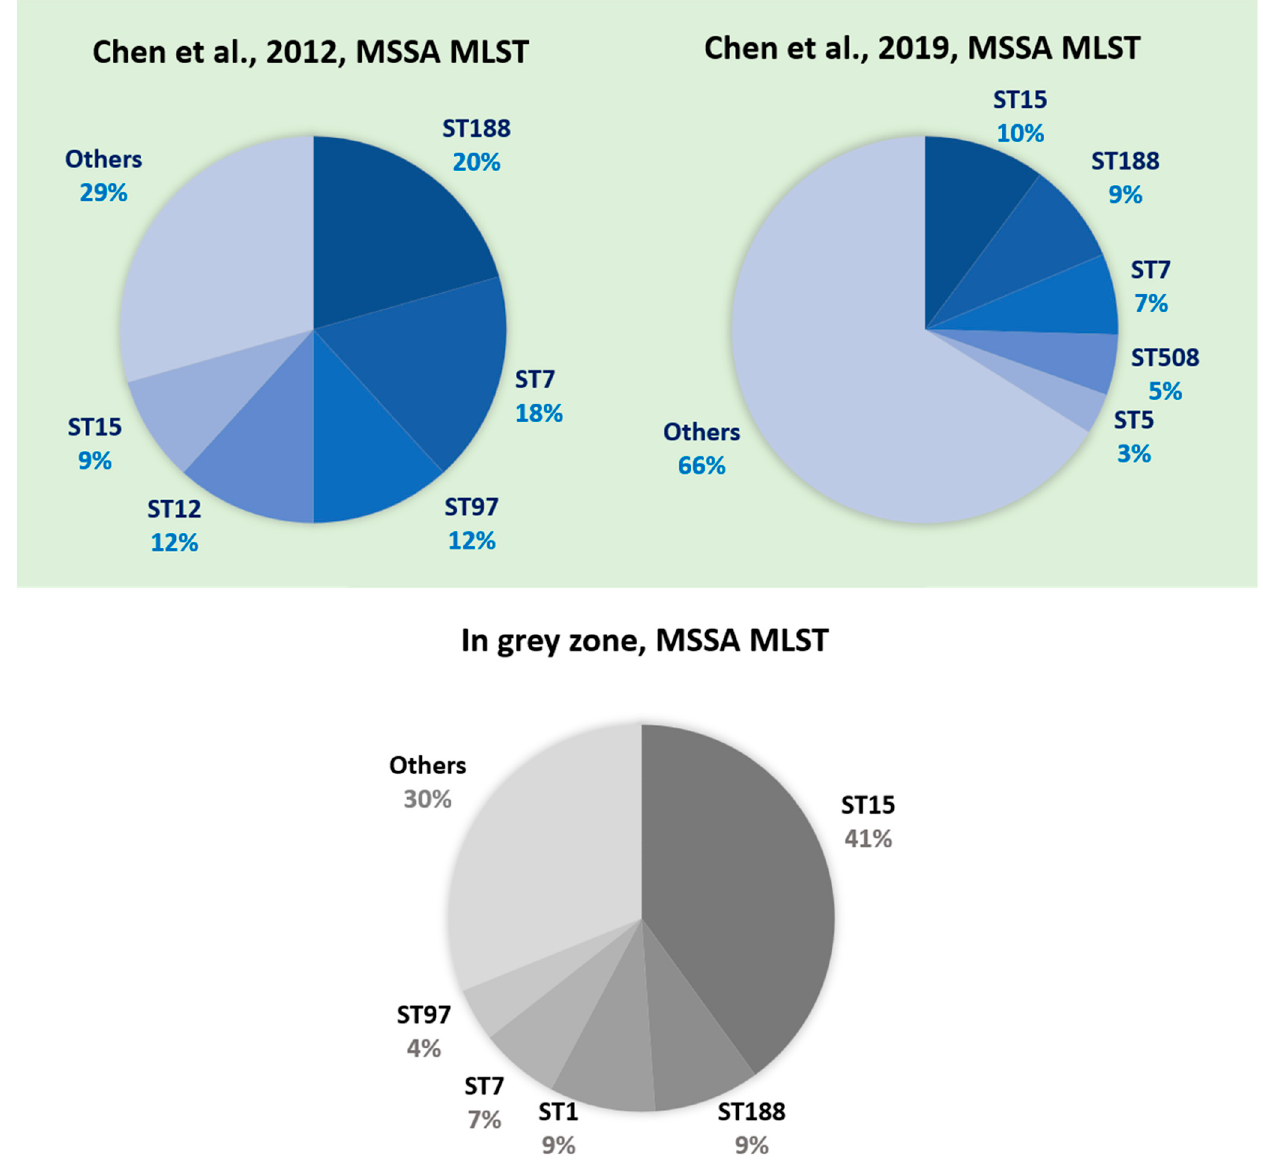
Figure 3. Distributions of multilocus sequence types for the MSSA isolates from Chen et al. [24], Chen et al. [25], and the grey-zone group in this study. The previous studies [24,25] showed that the common sequence types of MSSA infection in Taiwan were ST188, ST15, ST7, and ST97, but around 30–66% of MSSA isolates were other ST types. Similarly, in the grey-zone group of this study, MSSA strain types also show high diversity where 31% of MSSA isolates are not characterized in the top 5 common types (ST15, ST188, ST1, ST7, and ST97). Literature review of S. aureus epidemiology investigation in Taiwan is shown in Supplementary Table